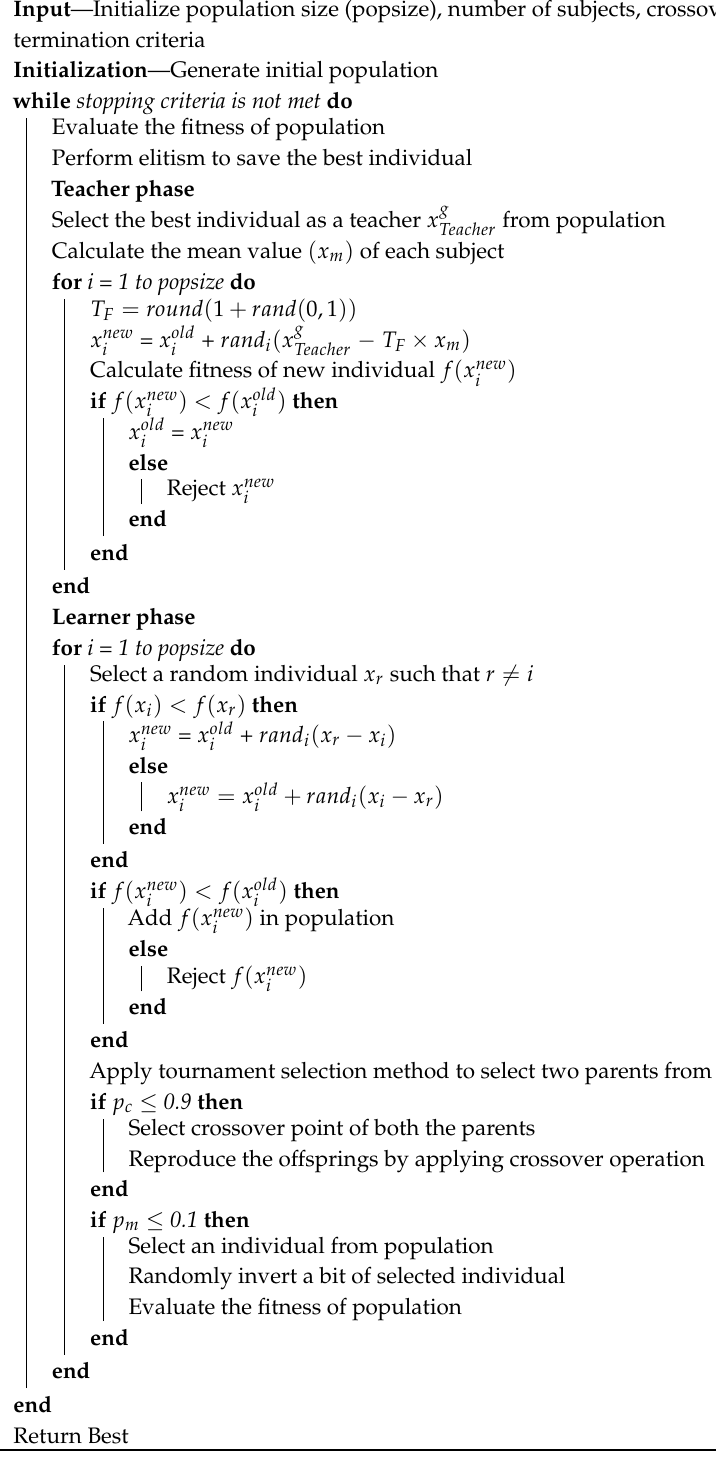
Algorithm 3: TLGO